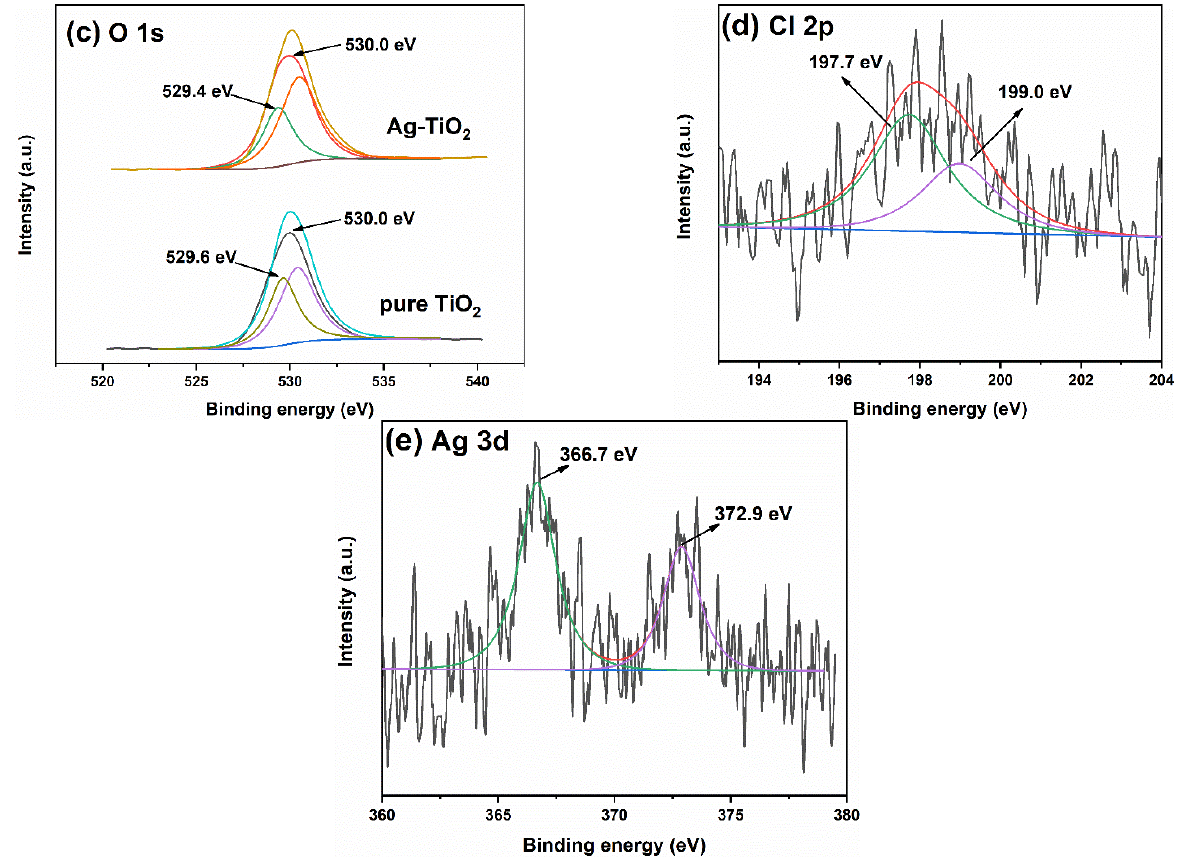
Figure 4. XPS spectra of pure TiO 2 and 4%Ag-TiO 2 : total spectra ( a ), Ti 2p ( b ), O 1s ( c ), Cl 2p ( d ) and Ag 3d ( e ).